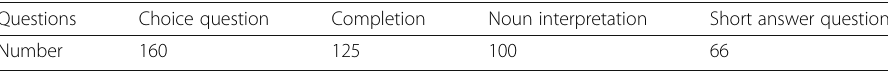
Table 1 The distribution of various types of questions Questions